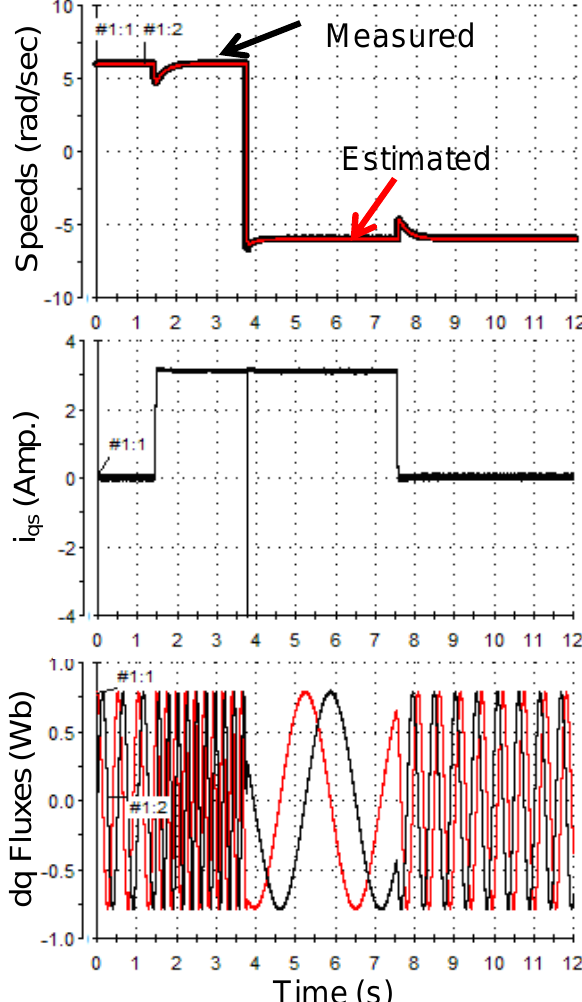
Figure 16. Practical tests at a speed reference of 0.04 p.u (6.28 rad/s) was changed − 0.04 p.u ( − 6.28 rad/s) with a rated T L change of +7 N.m applied at t = 2 s and removed t = 10 s.